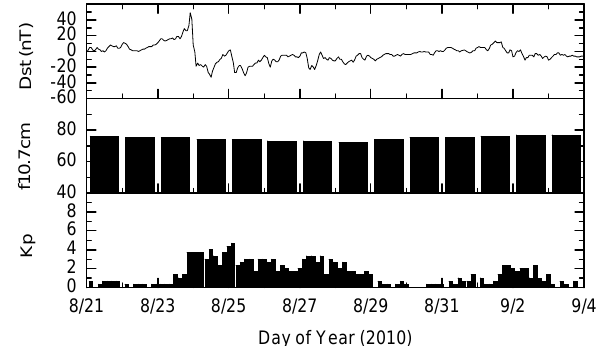
Fig. 12. Dst, F 10 . 7 , and K p indices during 21 August 2010 to